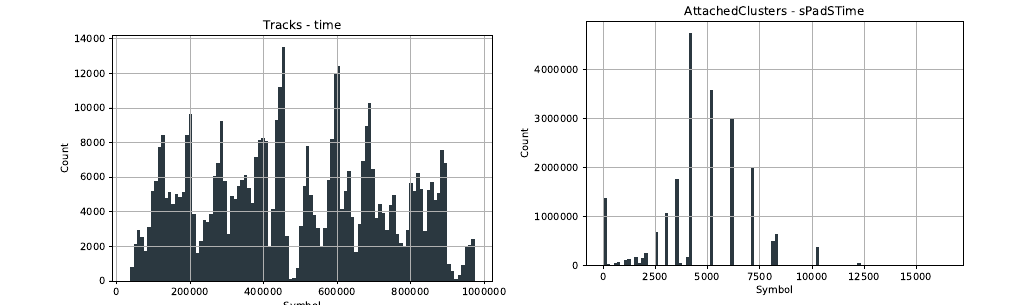
Figure 2: 2072849 symbol samples from Run 3 simulation containing 419 unique val- ues in a 16 Bit symbol range for object AttachedCluster , array sPadSTime . En- tropy of sample data is 6 . 06 Bit. Visualized with 100 bins.